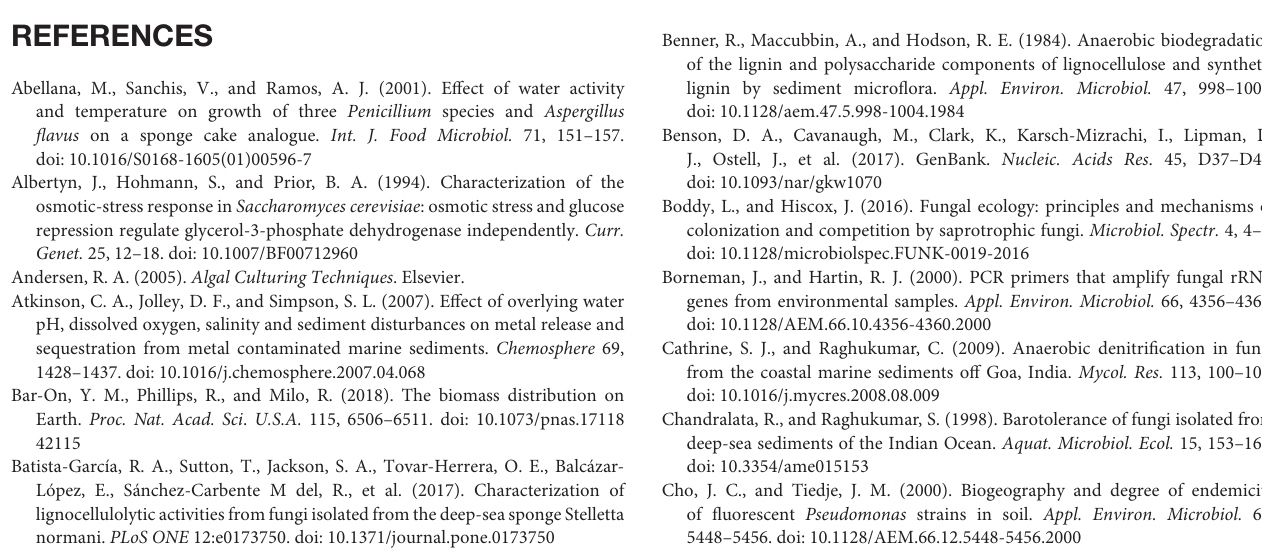
Supplementary Figure 1 | 18S rRNA transcript abundance within the sediment from SPG sites. Supplementary Table 1 | Colony characteristics. Supplementary Table 2 | Microscopic